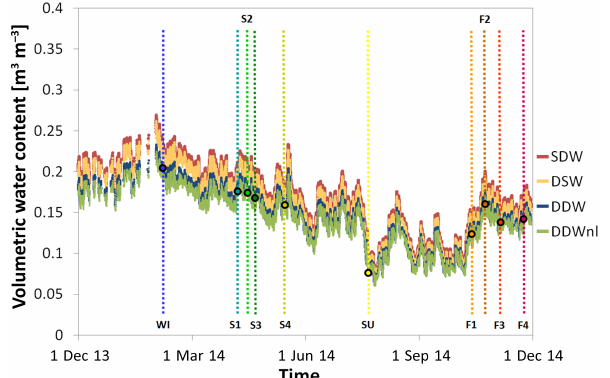
Figure 6. Time series of volumetric water content derived from modified calibration functions using parameters based on the four calibration approaches: simple depth weighting (SDW), depth- specific weighting (DSW), distance–depth weighting (DDW) and distance–depth weighting, nonlinear (DDWnl). Filled circles rep- resent the weighted average of volumetric water content obtained from soil cores at the time of calibration (weighting according to